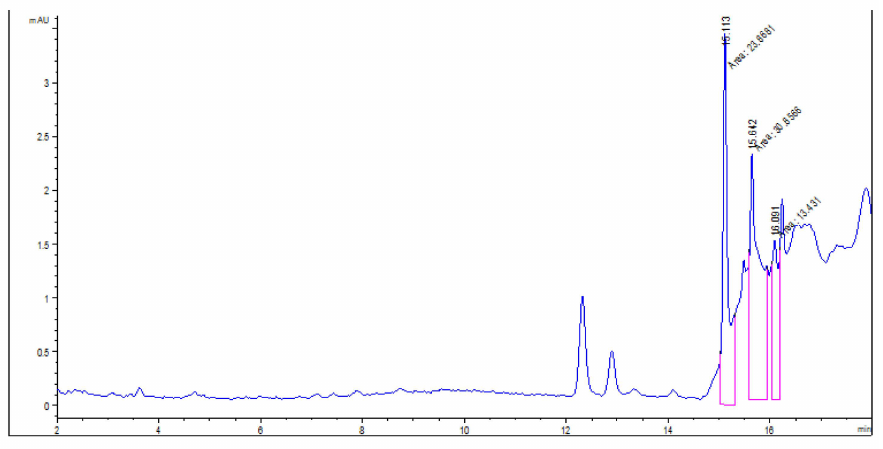
sence in acetone extracts (Table 3 and Figures 2 and 3).